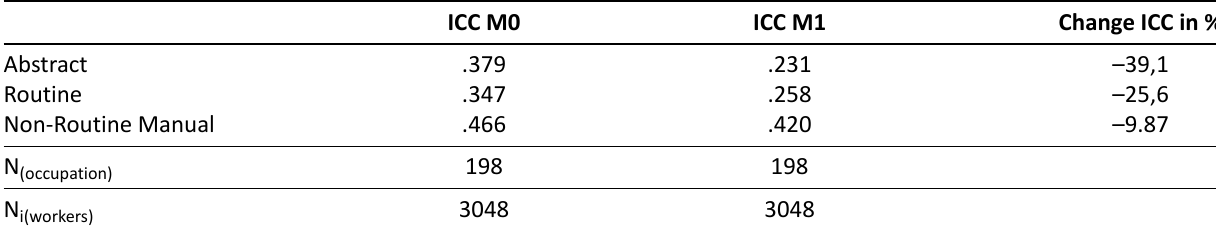
Table 4. ICCs for random intercept models of job tasks. Source: BIBB/BAuA Employment Survey 2012 and Supplemental Task Survey to the Employment Survey 2012.